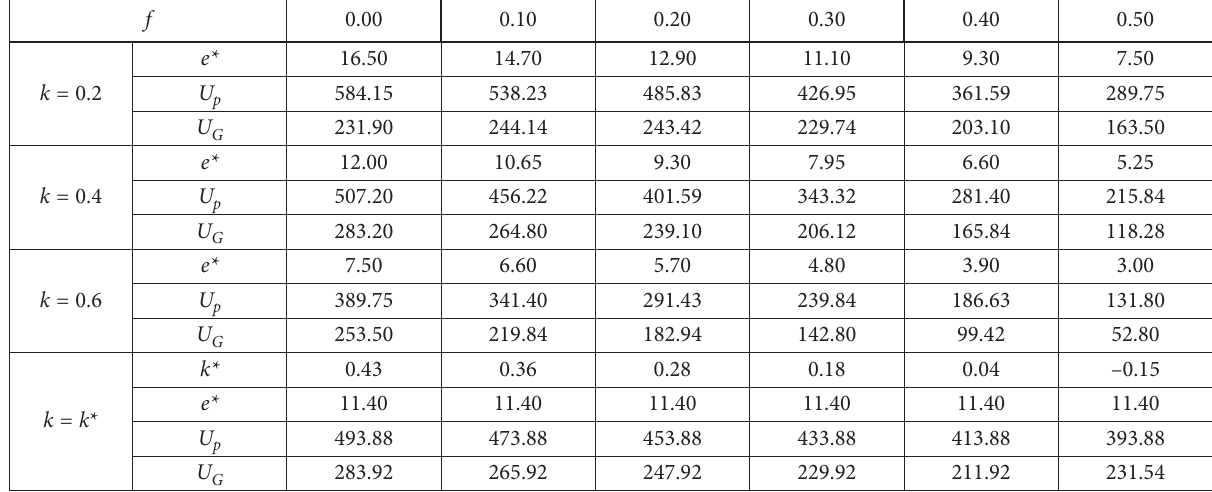
Table 1. The impact of default probability and revenue distribution on the